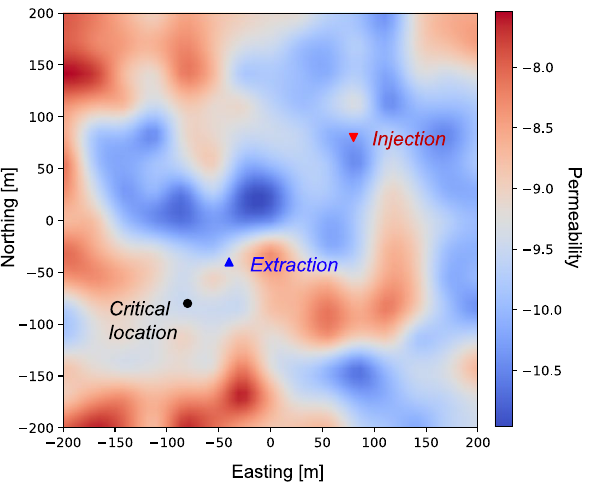
Figure 2. (Color online) Diagram of a single-phase pressure management with heterogeneous permeability field including one injection and one extraction wells, and a critical location. This figure was created using Julia Version 1.6.2 73,74 , and the DPFEHM framework 62 .